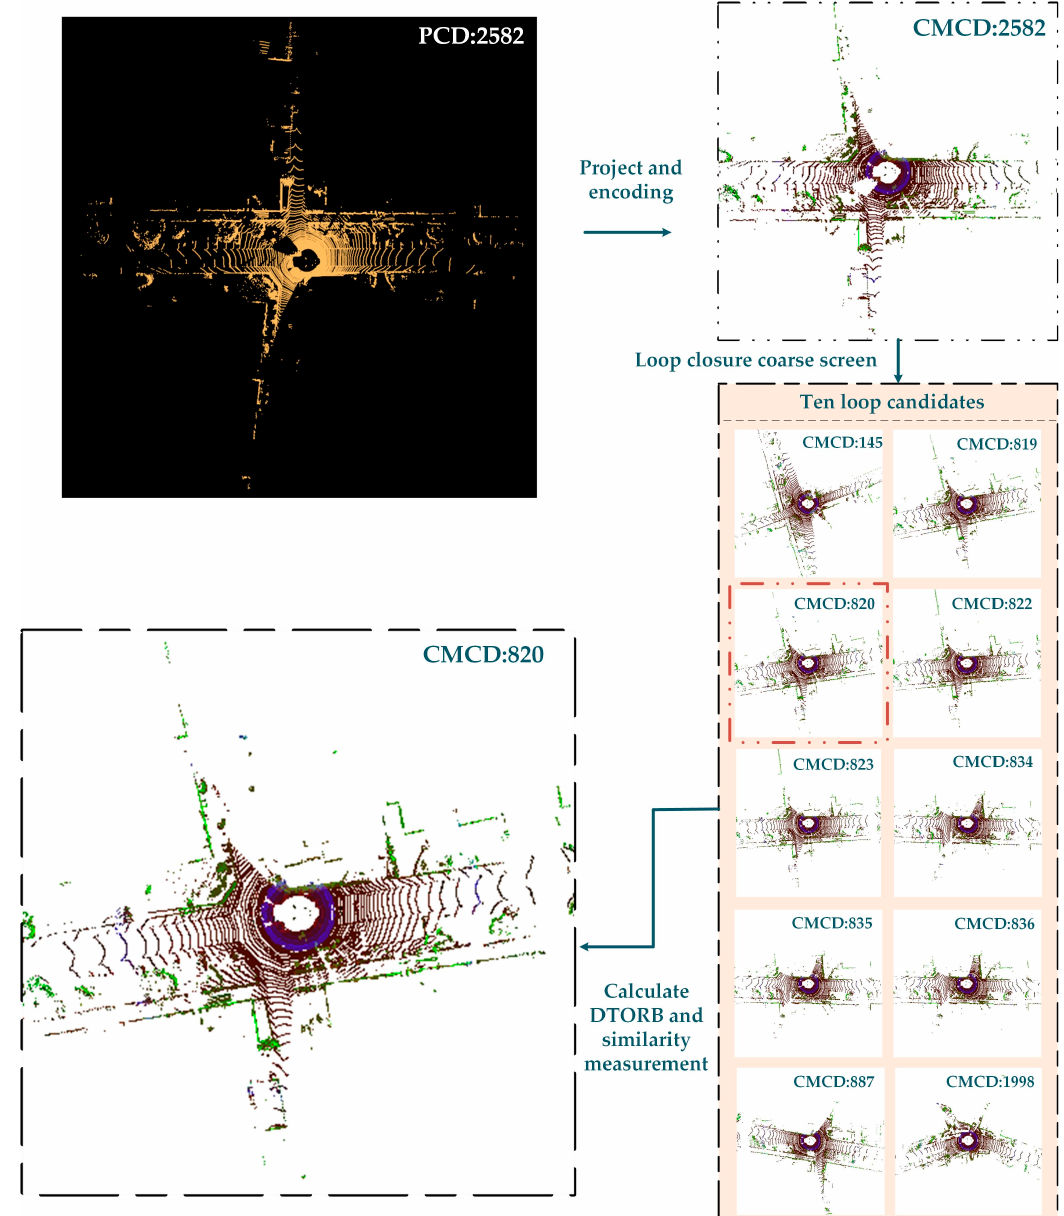
Figure 4. The execution result figure of selection of loop candidate: retrieve the ten most similar loop candidates of the point cloud at frame 2582 of KITTI-05.